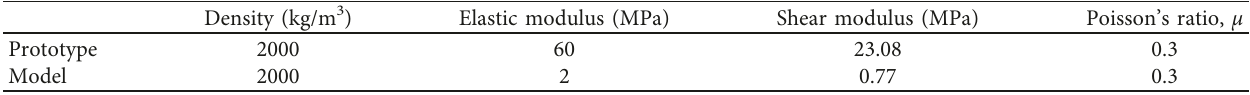
Table 3: Properties of the soils.